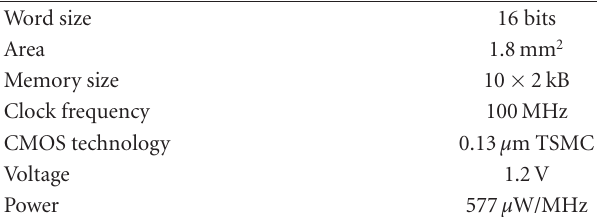
Table 2: Characteristics of the Montium TP.